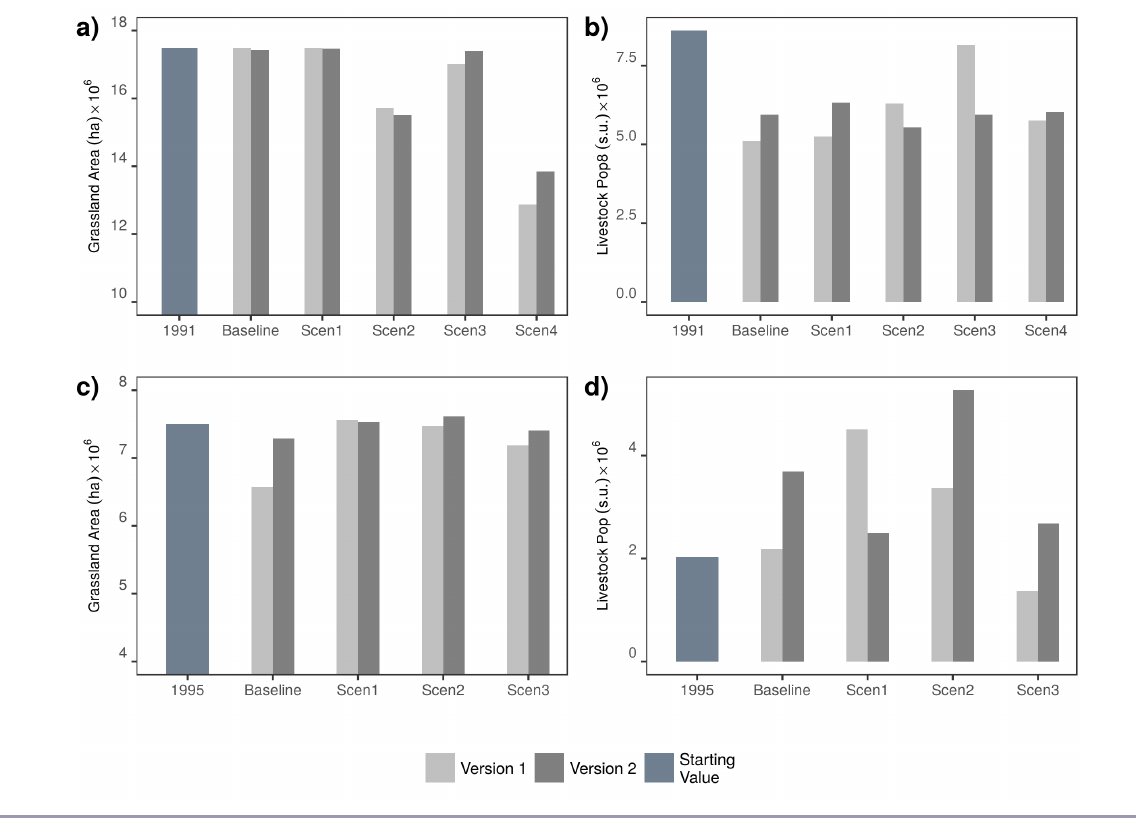
Fig. 4 . Example of how model projections changed for some variables and/or scenarios between the first and the final version of the modeling projections for 2050 for grassland area and livestock population for Xilingol, Inner Mongolian Autonomous Region (a, b) and Sukhbaatar, Mongolia (c, d) under each model scenario compared to the quantity at the start of